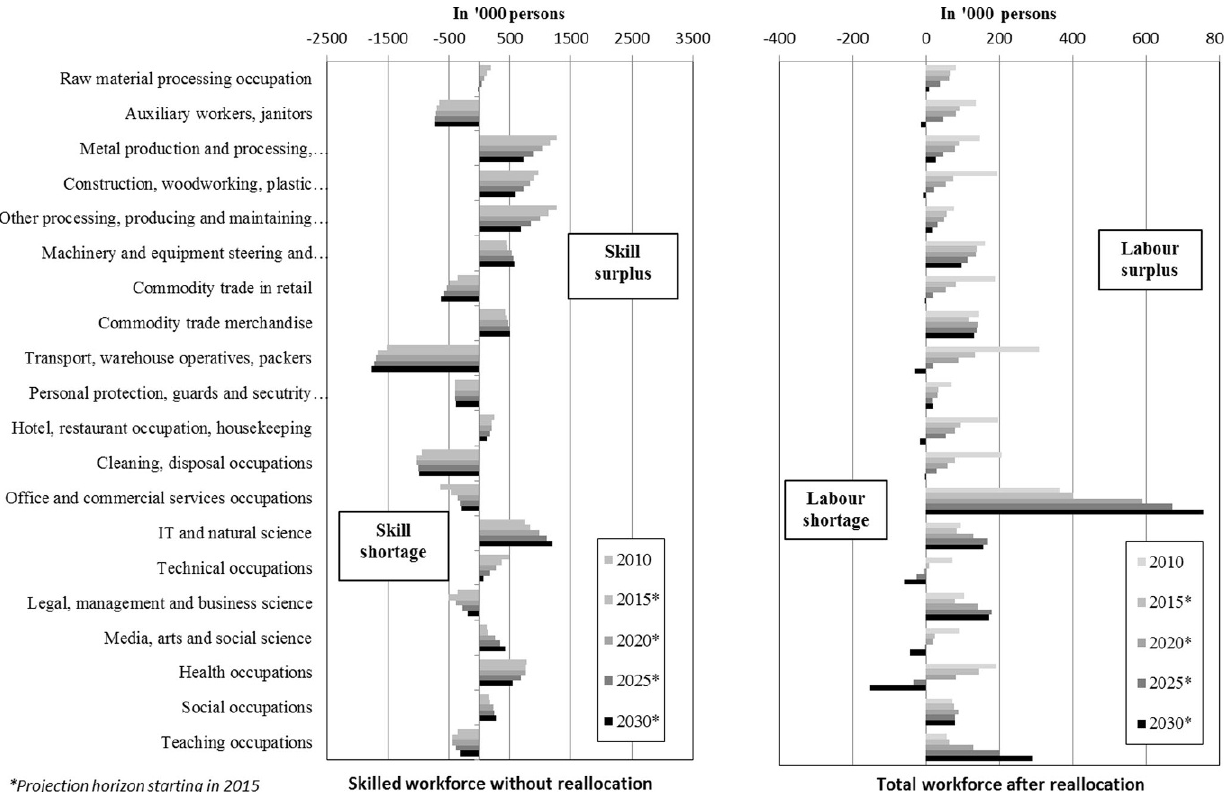
Fig. 2 Skill shortages and surpluses with and without reallocation in 2005–2030. Source: QuBe project 3 rd wave; own